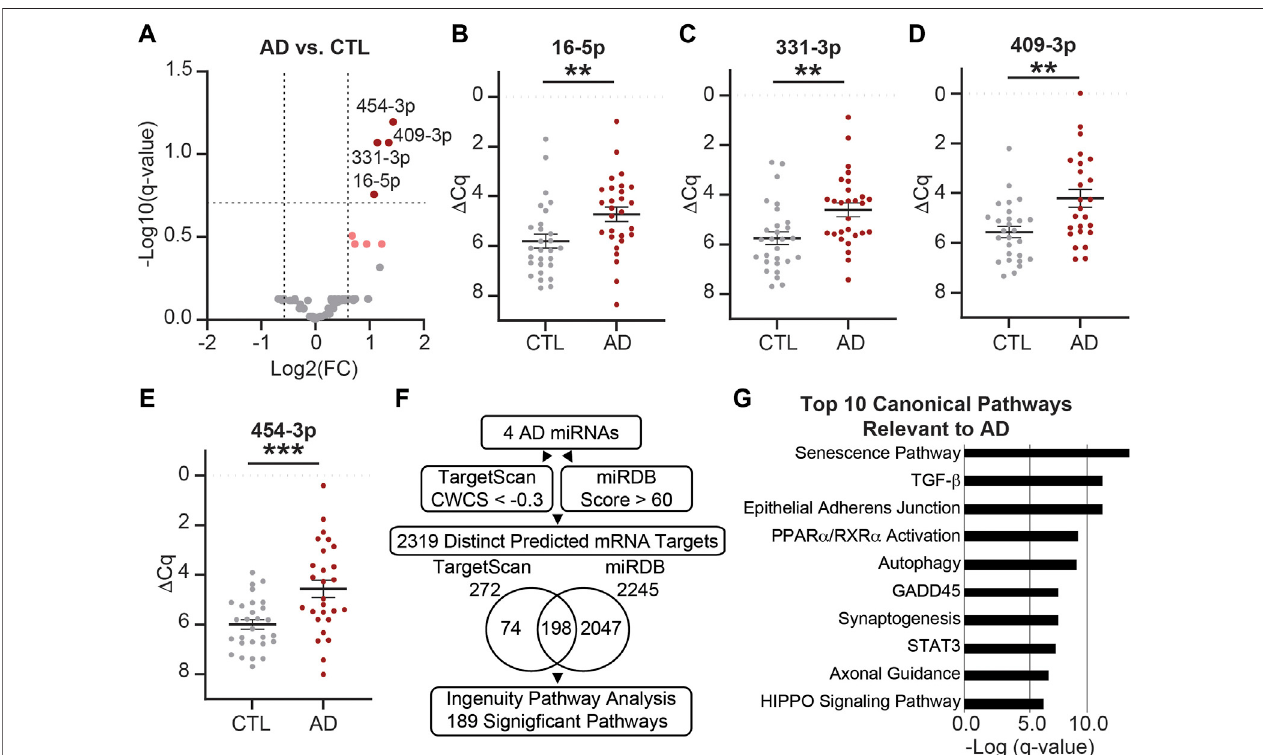
FIGURE 7| MiRNAs are differentiallyexpressed in AD vs. CTL CSF EVs. (A) Volcano plot shows fold change (FC) of71 miRNAs expressed in AD CSF EVs (n =28) vs.CTLCSFEVs(n=28).Theverticaldashedlinescorrespondto1.5FC,andthehorizontaldashedlinedesignatesthecutoffforstatisticallysigni fi cantmiRNAs(Welch ’ s unpaired t -test; p -value < 0.011 based on Benjamini – Hochberg false discovery rate (B-H FDR) 0.20). The miRNAs designated by dark red circles are signi fi cantly increased by at least 1.5 FC in AD. MiRNAs in pink have a 1.5 FC in expression with p-value < 0.05, but are below the B-H FDR threshold. (B – E) Normalized Cq ( Δ Cq) values for the four miRNAsthat are signi fi cantly increased in AD vs. CTL. Datashown as themean ±SEM and analyzed using Welch ’ s unpaired t-tests, ** p < 0.01 and *** p < 0.001. (F) Work fl owofthetargetpredictionanalysisforthefoursigni fi cantmiRNAs:miR-16-5p,-331-3p,-409-3p,and-454-3p.MiRNAs werequeriedusing TargetScan 7.2 with a CWCS of < − 0.3 (272 MiRNAs total) and miRDB with a target score > 60 (2,245 MiRNAs total). The Venn diagram shows the overlap in miRNA targetspredictedbyTargetScan7.2andmiRDB.Ofthe2,319predictedmRNAtargets(74fromTargetScan+2047frommiRDB+198incommontoboth),weidenti fi ed